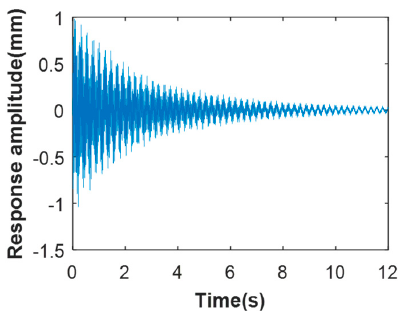
Figure 7. Acceleration response. Table 1. First natural frequencies (Hz) of the submerged cantilever beam.